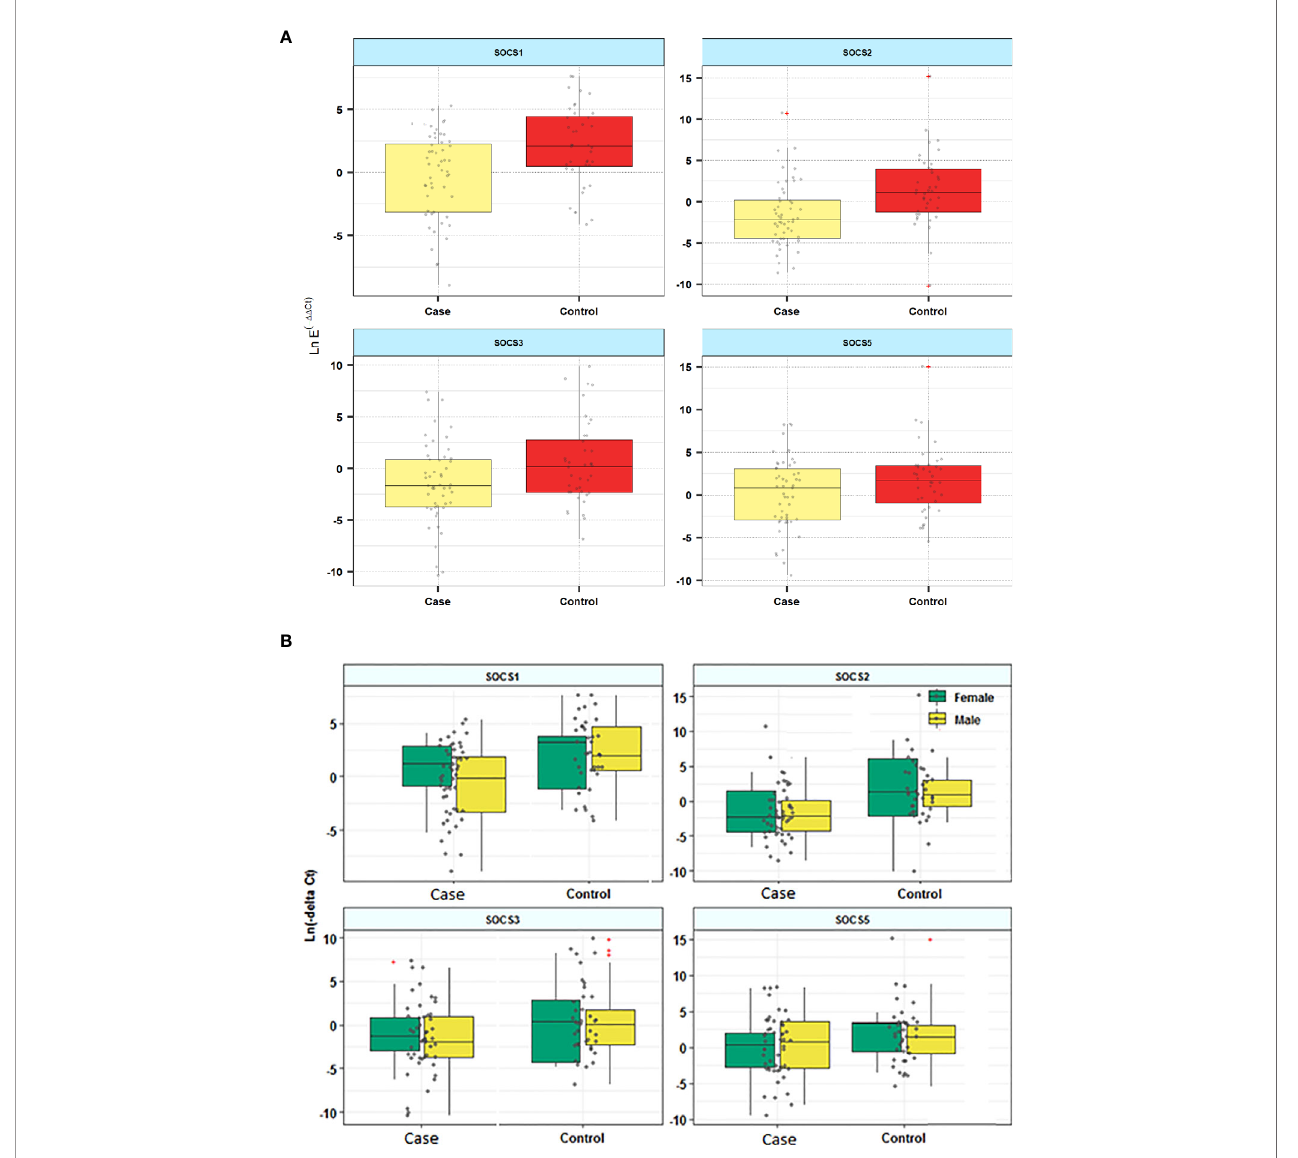
FIGURE 1 | Relative expression of SOCS genes in patients and controls (A) and based on the gender of study participants (B)